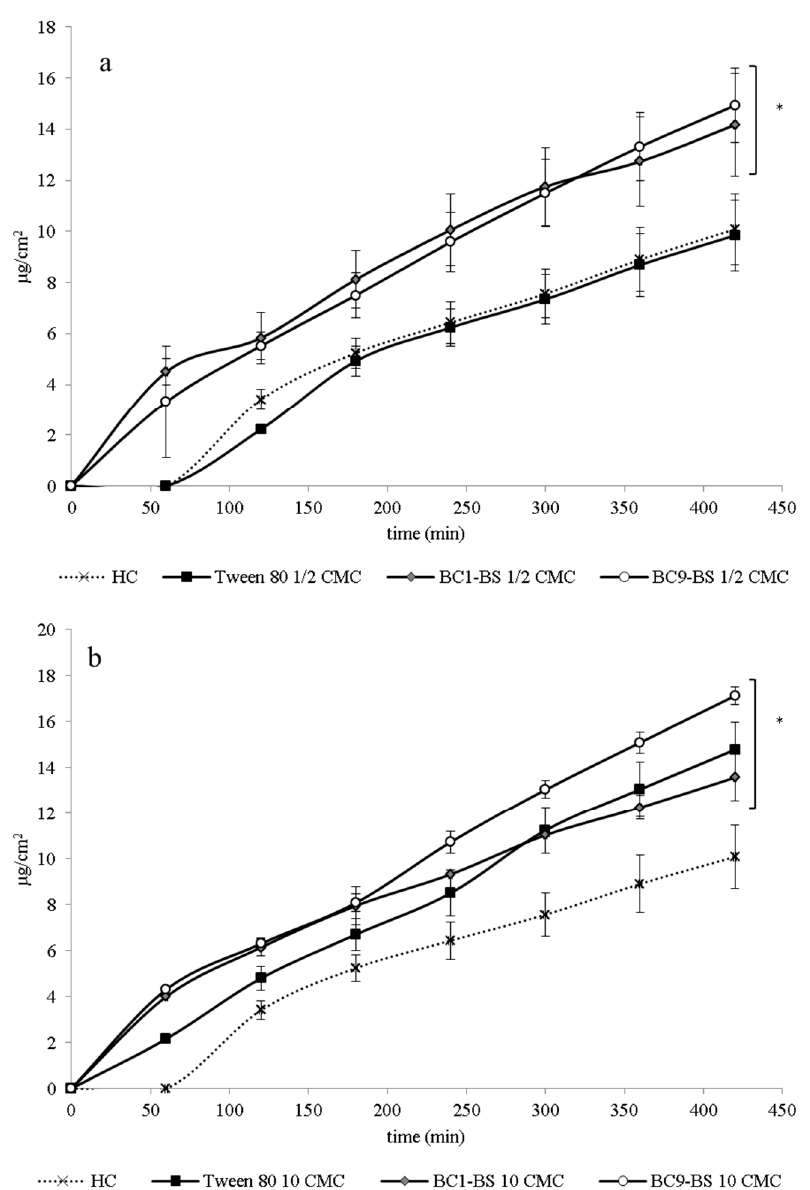
Figure 4. Permeation profiles through porcine skin of HC in the absence and presence of different concentrations of surfactant: ( a ) concentrations below CMC (1/2-fold lower than CMC); ( b ) concen- trations above CMC (10-fold higher than CMC). Data are expressed as means ± SD, n = 5. Significance indicated by * = p < 0.05 compared to the control.